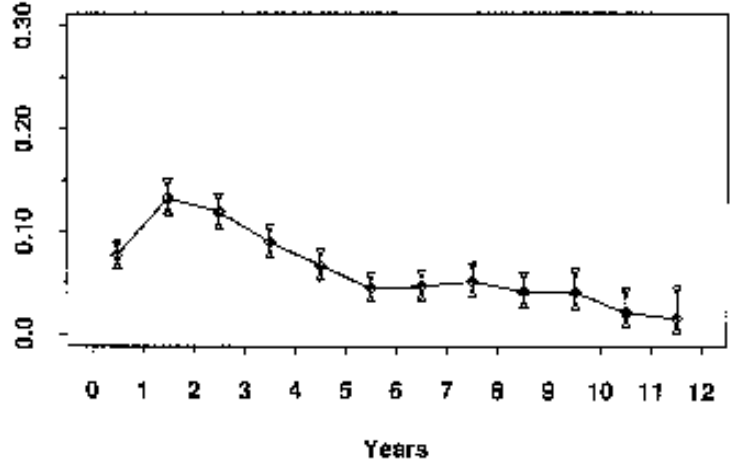
Figure 4. Saphner et al. data (Saphner et al . ECOG trials, Hazard of Relapse). These data which combine approximately 10 clinical trials for a variety of controls and adjuvant therapies clearly show bimodal hazard. The error bars are small as a result of the large number of patients. Modified from Saphner et al. [39]. ECOG is the Eastern Cooperative Oncology